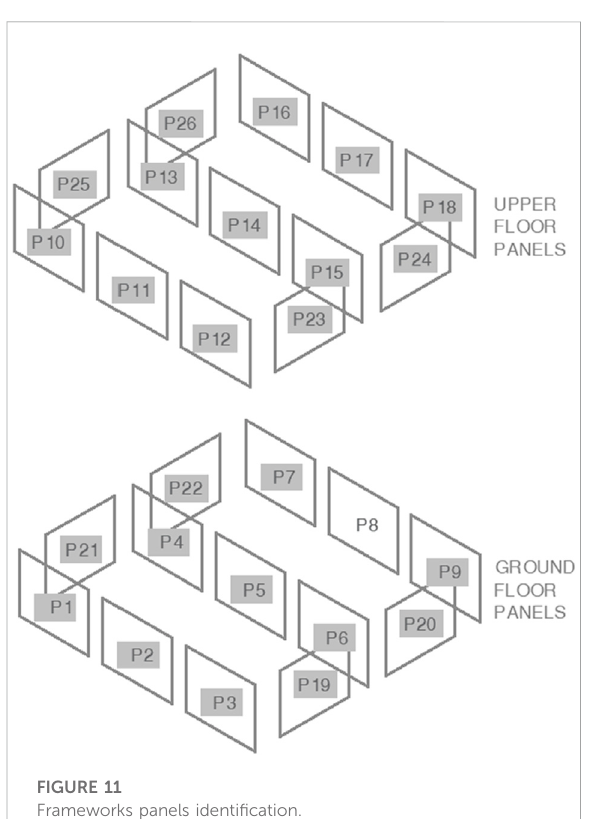
FIGURE 11 Frameworks panels identi fi